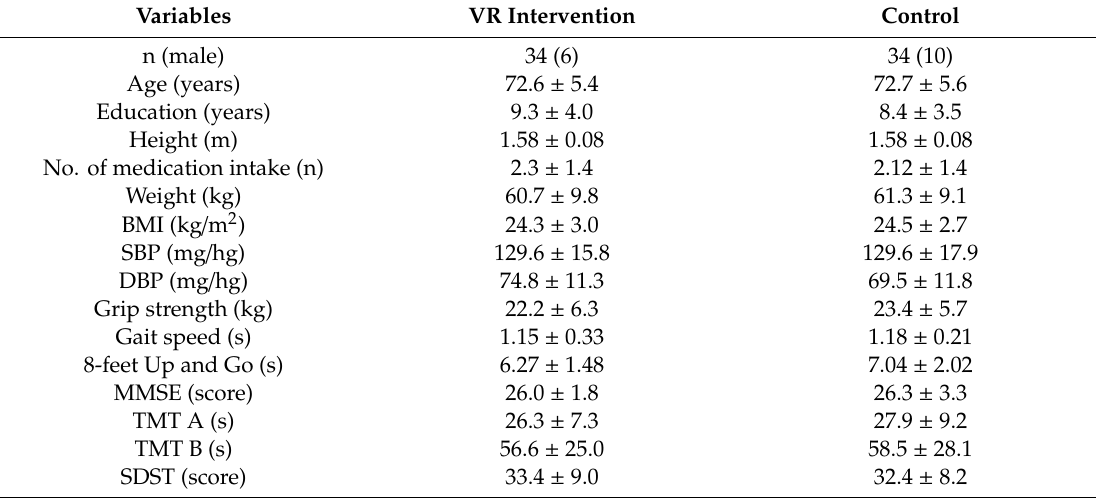
Table 1. Selected anthropometric, cognitive and physical function characteristics of the subjects at the baseline.